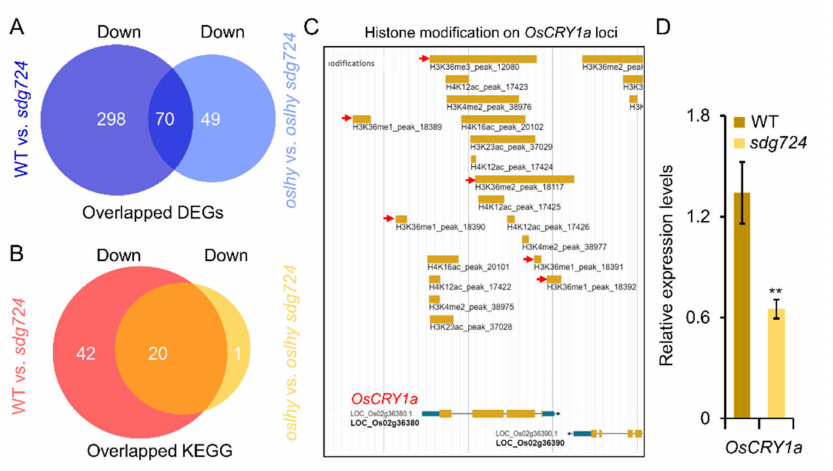
Figure 4. Candidate targets analysis of SDG724. ( A ) Overlapped downregulated DEGs between WT vs. sdg724 and oslhy vs. oslhy sdg724 comparisons. ( B ) Overlapped KEGG pathways between WT vs. sdg724 and oslhy vs. oslhy sdg724 comparisons. ( C ) Histone modifications around OsCRY1a loci. The data is from Erice epigenomic platform (http://www.elabcaas.cn/rice/index.html, accessed around 16 April 2022). ( D ) qRT-PCR validation of candidate target genes in clock pathway. Down indicates the downregulated DEGs. Asterisks indicate statistically significant differences by a Student’s t -test (** p <